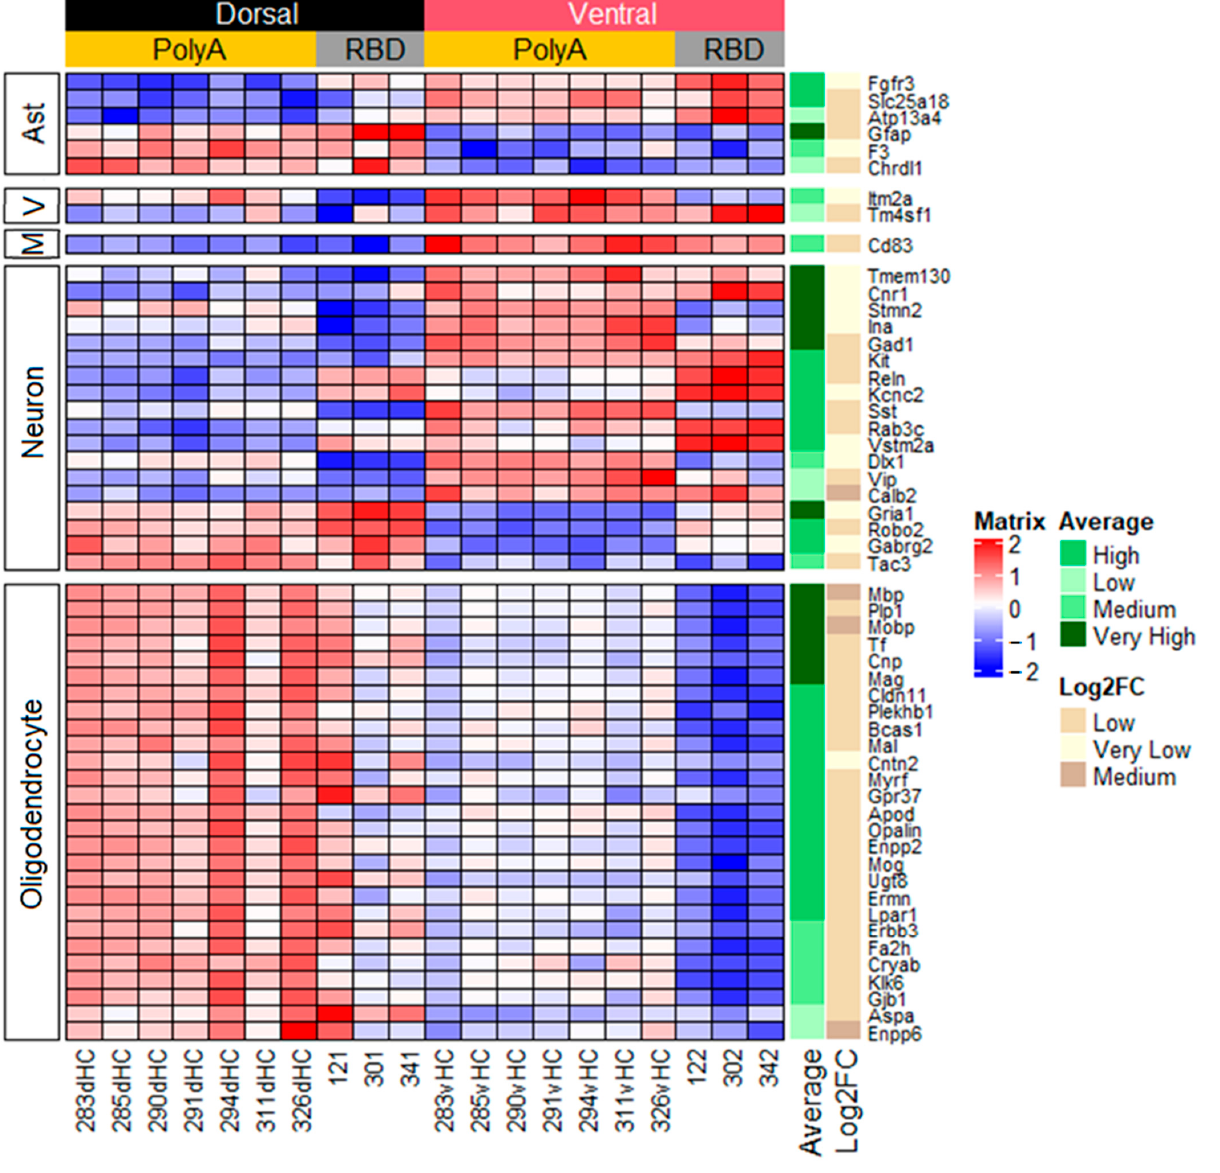
Figure 4. Heatmap showing DE genes, present in lists of top 30 most expressed cell-type-specific genes from [19]. Ast, astrocytes; V, vascular cells; M, microglia. All other designations are identical to Figure 2.